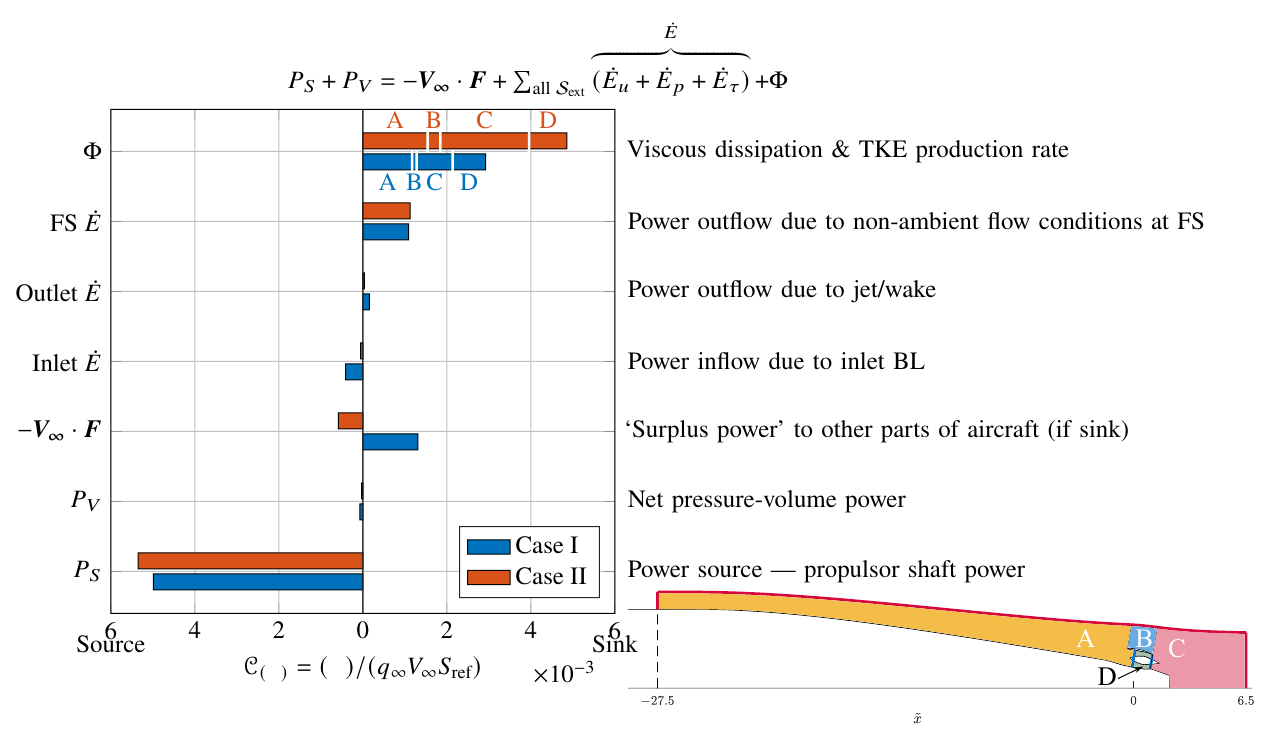
, full 360° fuselage. The dissipation rates Φ have V